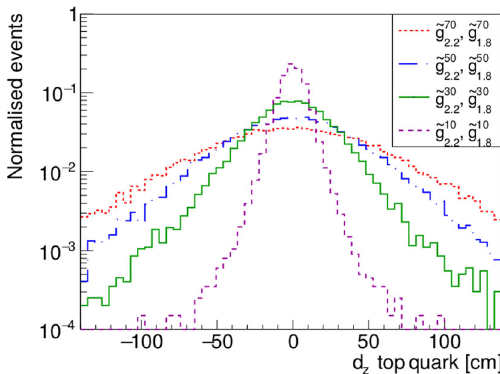
Fig. 72 d z distributions for the eight benchmarks with a magnetic field of B = 3 . 8 T